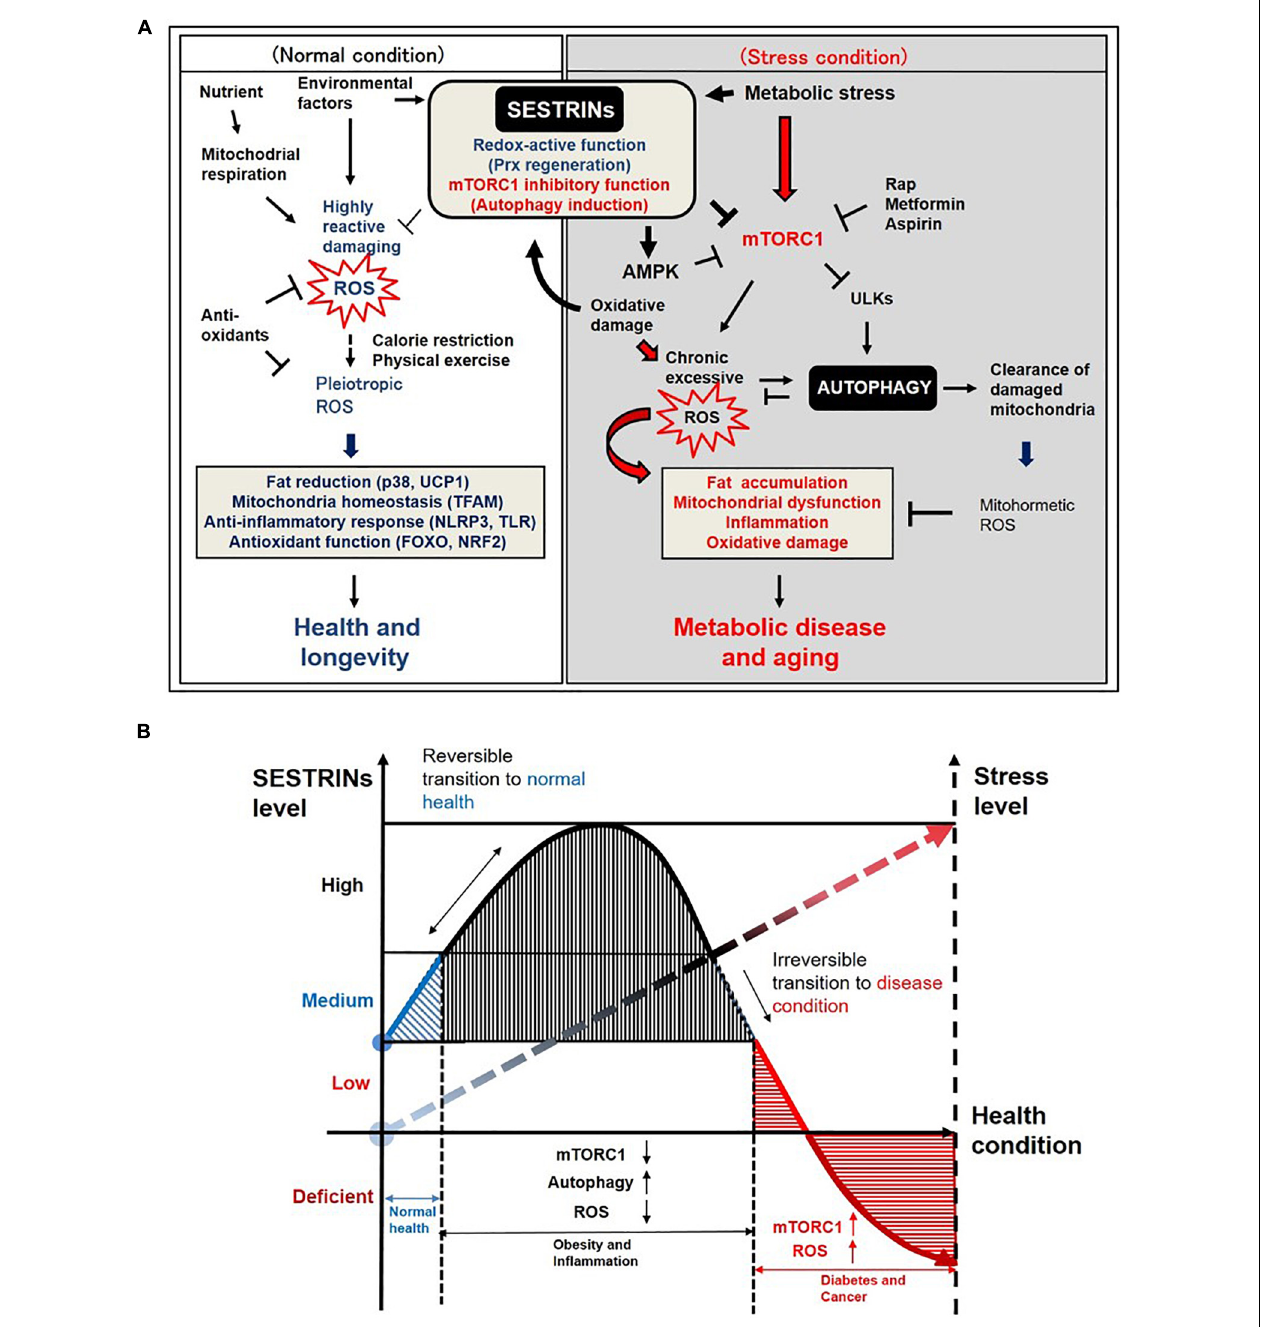
FIGURE 2 | Diagrams depicting the roles of Sestrins in managing stress levels and health conditions. (A) Diagram depicting the possible roles of Sestrins in the regulation of ROS and autophagy in mammalian cells. ( Normal condition ) Redox-active function of Sestrins may suppress highly reactive damaging ROS and maintain pleiotropic ROS level such as mitohormesis in mammalian cells under normal nutrient and environmental factors. ( Stress condition ) Sestrins are induced by metabolic or genotoxic stresses such as overnutrition and oxidative damage. Chronic activation of mTORC1 may induce chronic excessive ROS, which results in aging-associated phenotypes such as fat accumulation, mitochondrial dysfunction, inflammation, and oxidative damage in mammalian cells. However, Sestrins inhibit mTORC1 activity and subsequently induce or regulate autophagy activity in the cells and tissues. Activated autophagy removes oxidized proteins and also clear damaged mitochondria which are producing excessive harmful ROS. Overall, Sestrins-mediated autophagy regulates the ROS level to trigger redox adaptations under stress conditions. The underlying mechanism of how pleiotropic level of ROS is maintained by Sestrins-mediated autophagy signaling pathway needs further investigation. (B) Graphic diagram explaining the correlation between Sestrins and stress levels in health and disease conditions.